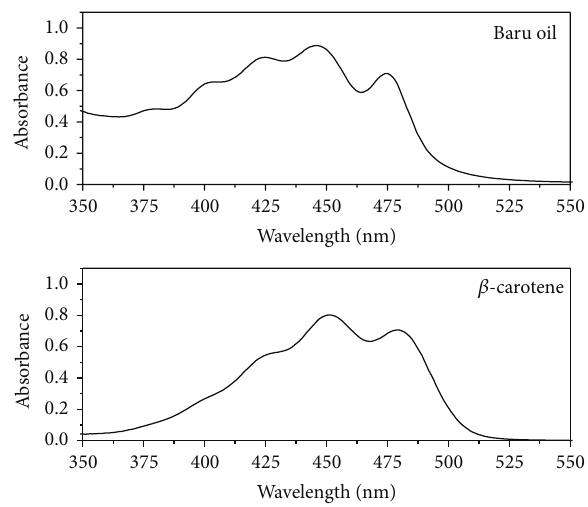
Figure 2: Baru oil and 𝛽 -carotene absorbance between 350 and 550 nm. All samples were diluted in